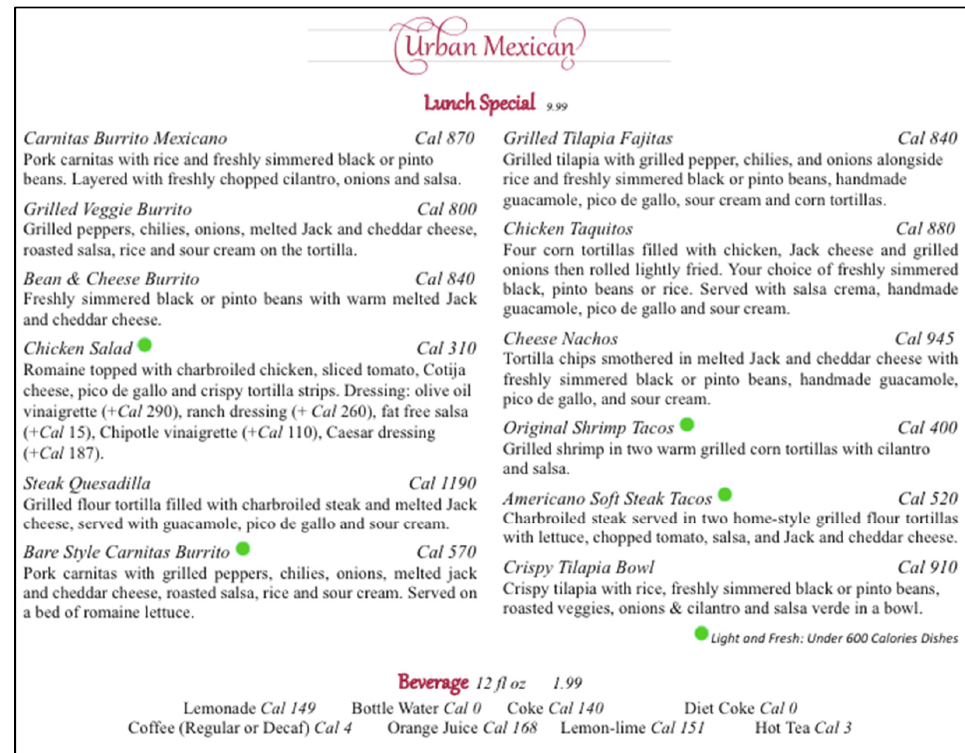
Figure A11. Urban Mexican Sweet Spot Menu.